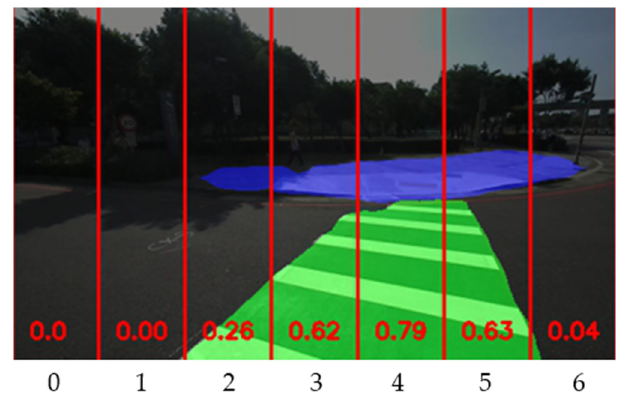
Figure 5. Seven divisions with Conf s .